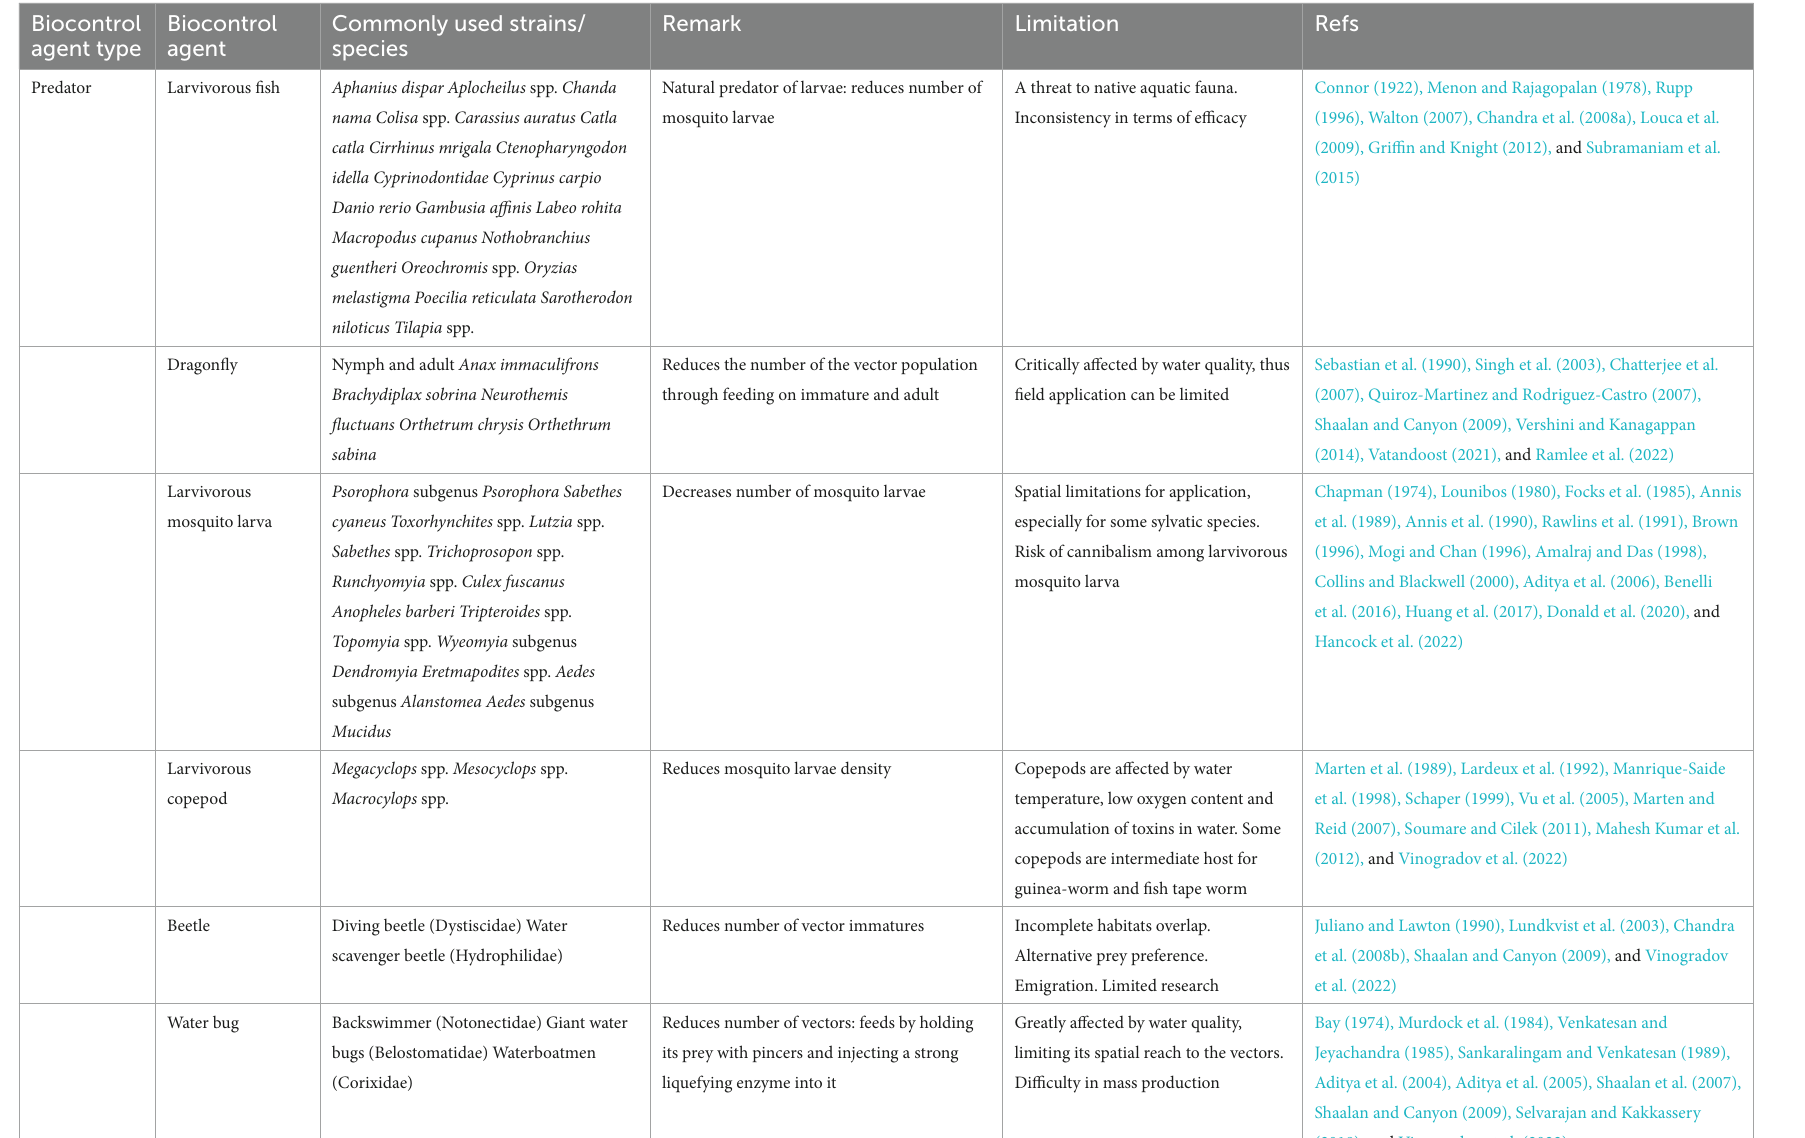
TABLE 3 List of available vector biocontrol